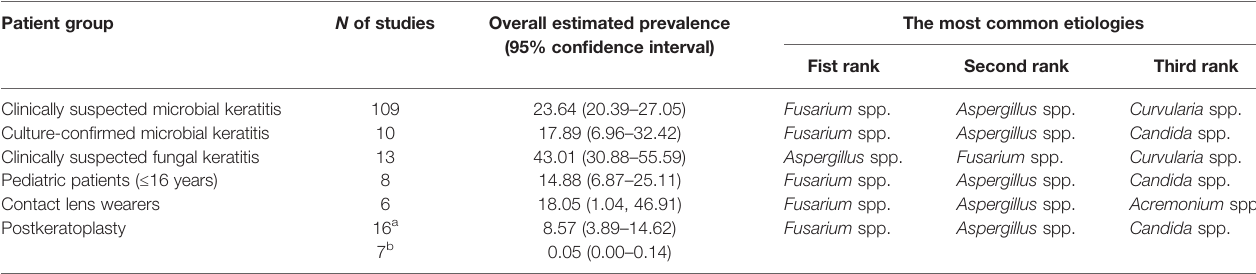
TABLE 1 | Summary of overall estimated prevalence values and the three most common causes of fungal keratitis among various groups of patients included in the present meta-analysis (1990 to 2020). Patient